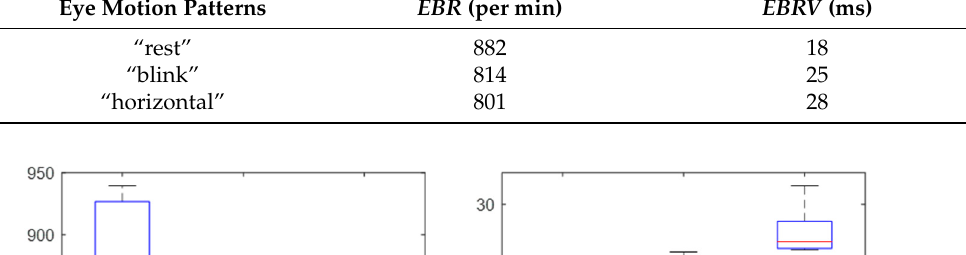
Table 5. The outcomes of the wireless wearable EOG interface. (2 s time period, 6-sample average). Eye Motion Patterns